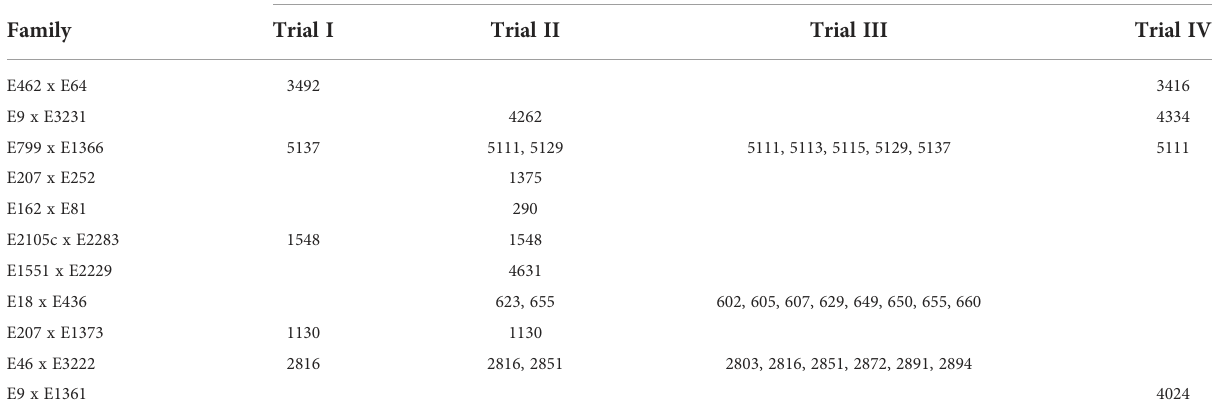
TABLE 1 SE lines and families used in different